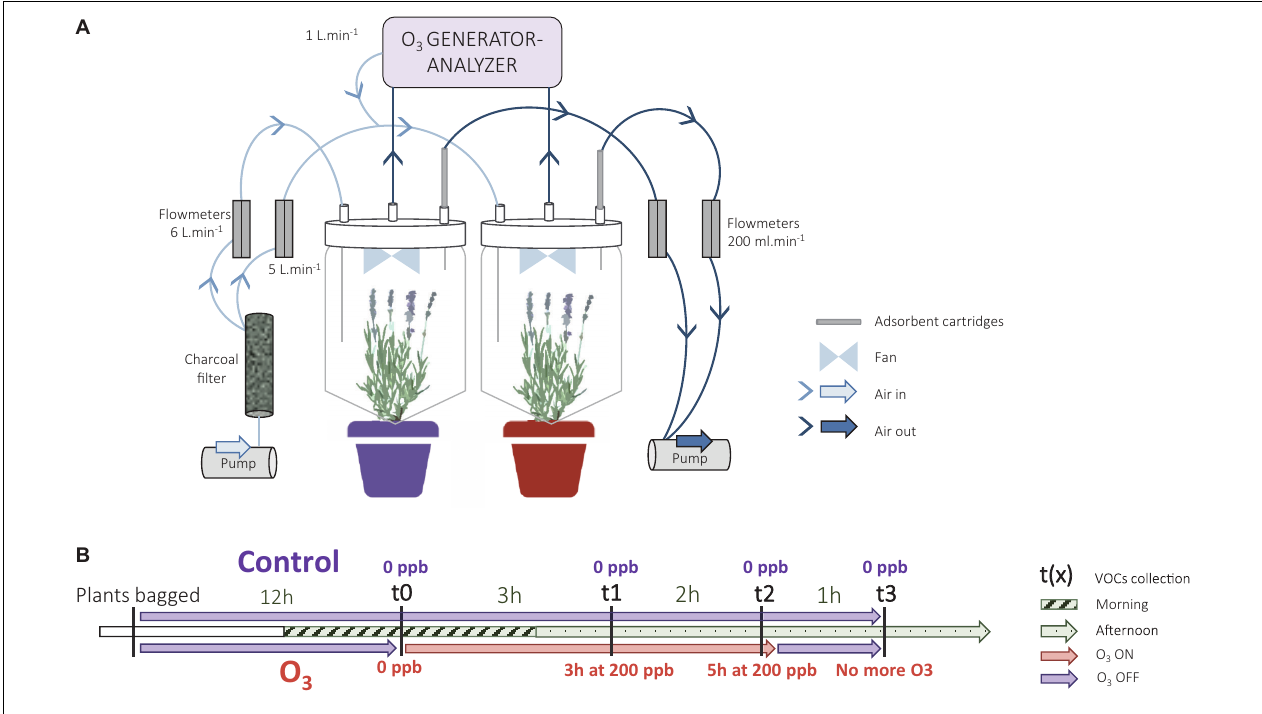
FIGURE 1 | Schematic diagram of (A) the experimental set-up and (B) timeline used for flowering lavender exposure to high O 3 level in experiment 1. Control lavender plants, represented by the purple color in the figure, were exposed to 0 ppb O 3 during the entire experiment. Treated lavender plants, represented by the red color in the figure, were exposed to 200 ppb of O 3 from t1 to t2 (red pot). After t2, O 3 generation was stopped and 30 min to 1 h later the VOCs were collected in the chamber. t times correspond to collections of VOCs through adsorbent cartridges during 10 min (gray bars in panel A ) in the two